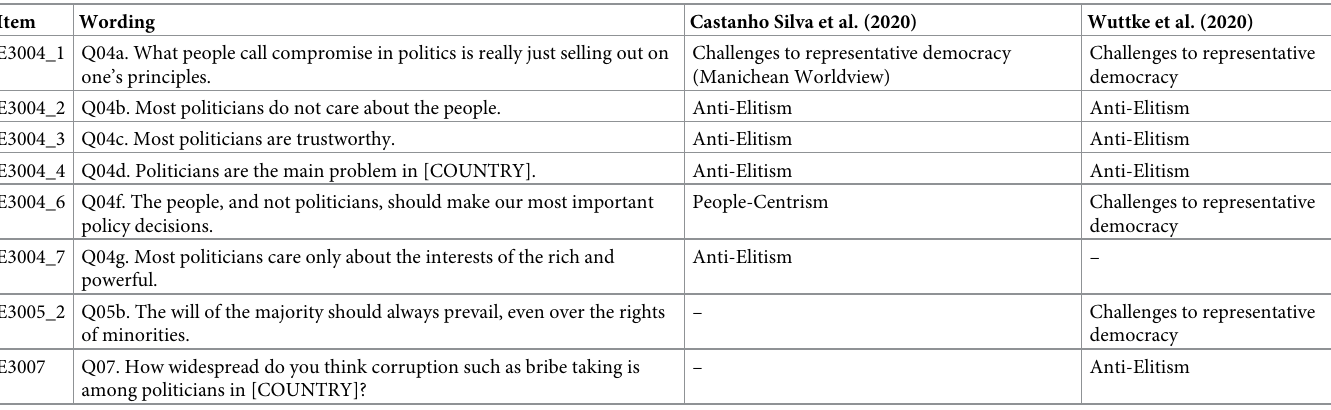
Table 1. Populist attitudes items in the CSES Module